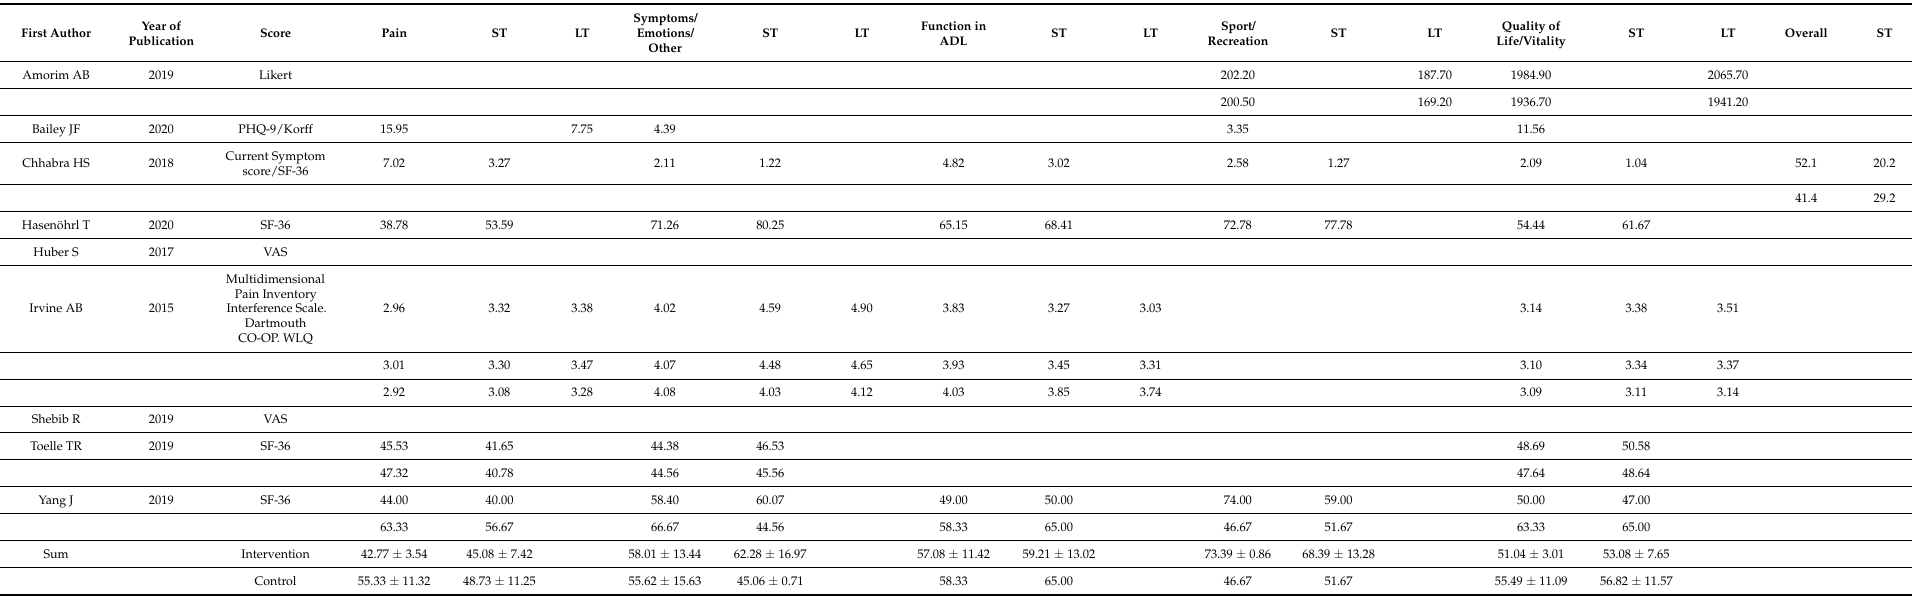
Table 4. PROMs following rehabilitation programs for back pain and following spine surgery. Score indicates the PROM used; overall means, standard deviations and p